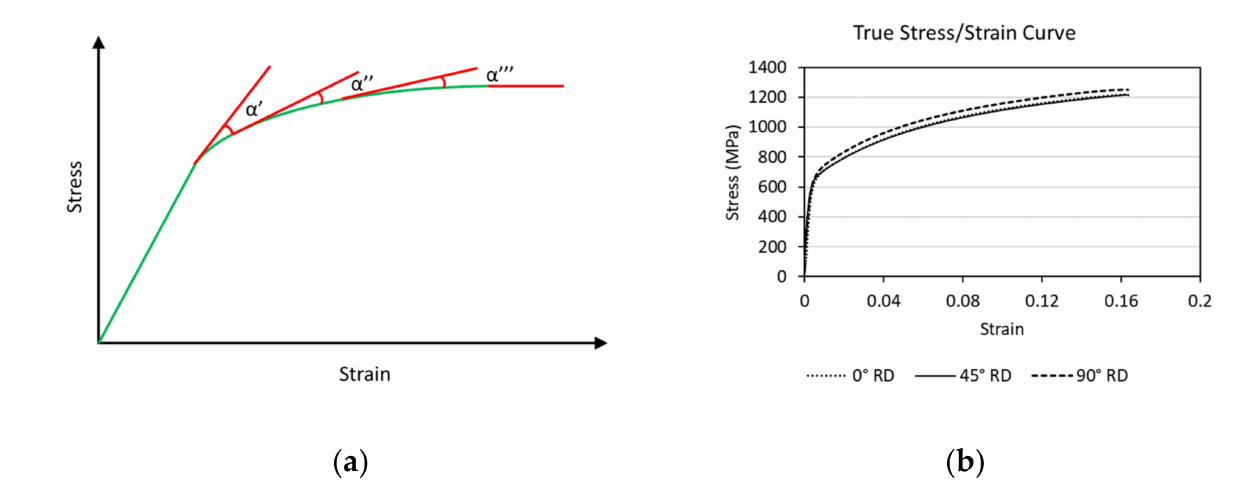
Figure 9. ( a ) Softening effect in stress–strain curve; ( b ) true stress–strain curve of TRIP1000 at 0 ◦ , 45 ◦ and 90 ◦ in relation to rolling direction (RD).